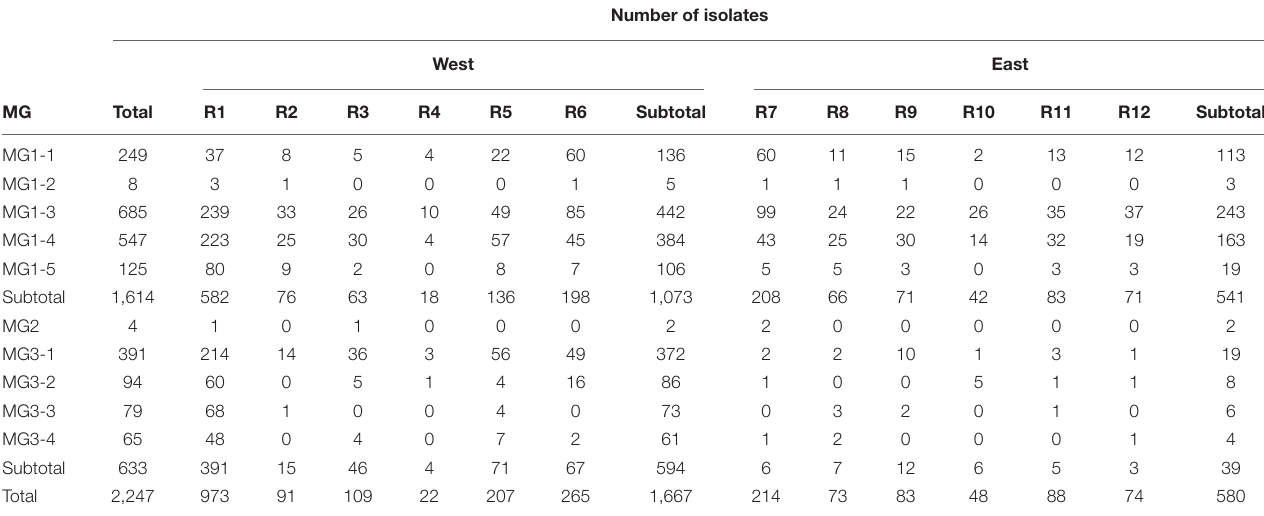
FIGURE 7 | Membership probability for each Puccinia striiformis f. sp. tritici ( Pst ) isolate in each submolecular group (MG) from discriminant analysis of principal components (DAPC) analysis. Pst isolates are organized by 8 years given at the bottom (A) . Histogram of the numbers of isolates clustered in the 10 MGs from the 8 years (B) . TABLE 7 | Numbers of Puccinia striiformis f. sp. tritici isolates in the molecular groups (MGs) identified using hierarchical cluster analysis across the 12 epidemiological regions in the United